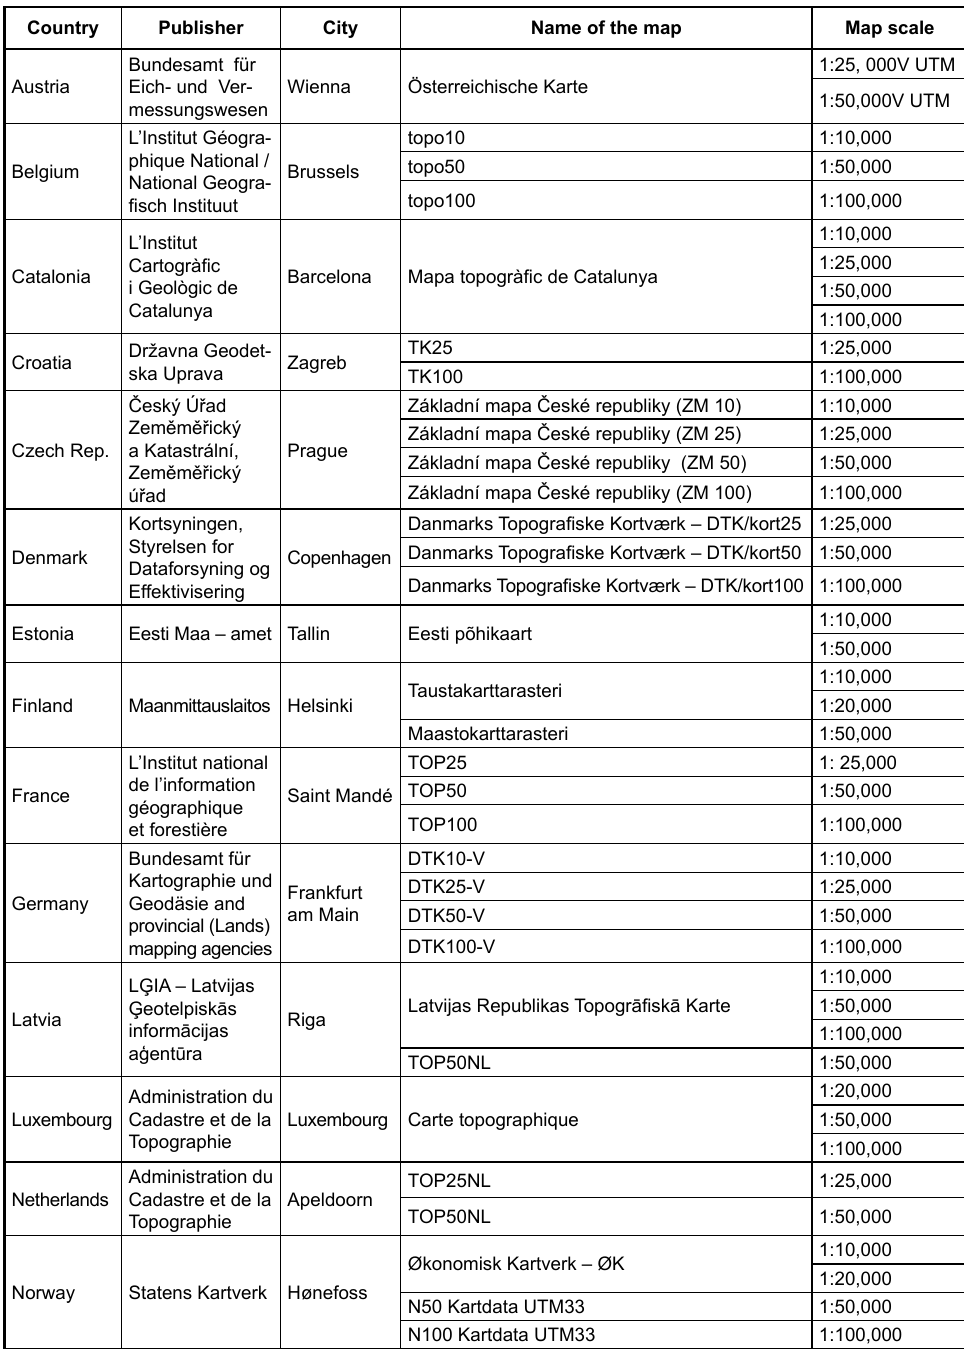
Table 1. List of maps used as a basis for the analysis